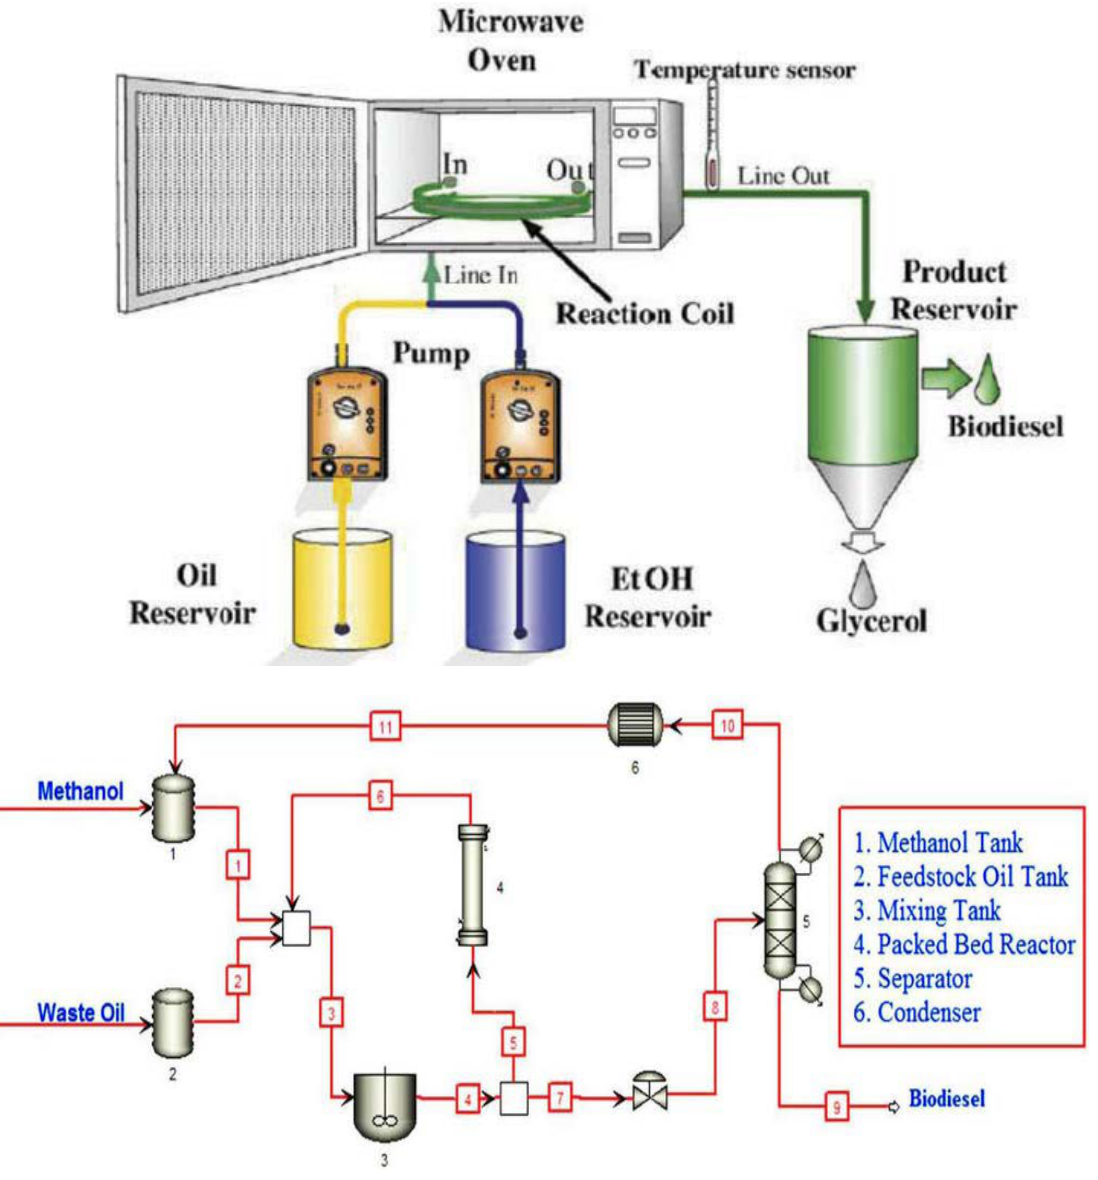
Figure 7. Schematic representations of a continuous flow reactor for biodiesel production. Adapted from [66,67]. Table 5. Merits and demerits of batch, semi-batch, and continuous reactors. Reactor Modes